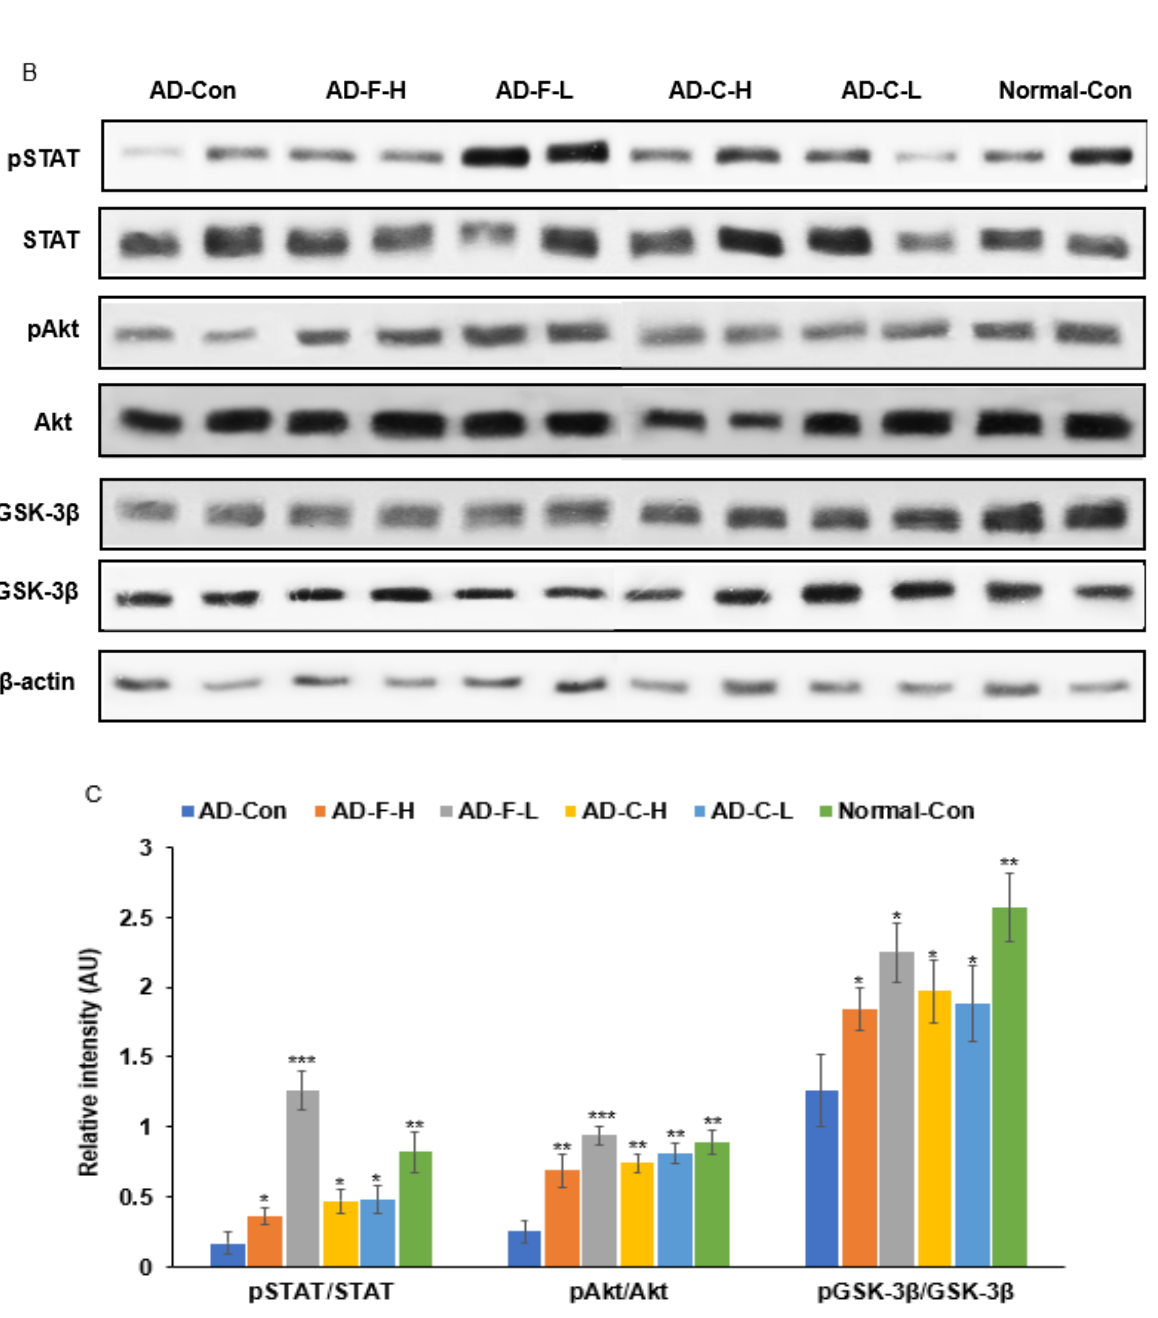
Figure 4. Hippocampal neurotransmitter expression and insulin signaling pathways. ( A ) mRNA expression of ciliary neurotrophic factor (CNTF) and brain-derived neurotrophic factor (BDNF). ( B ) Protein and phosphorylation of proteins in insulin signaling pathways. ( C ) The intensity of proteins and phosphorylation in insulin signaling pathways. The bars and error bars represent the means ± standard deviations ( n = 4). Hippocampal amyloid- β (25–35) infused rats were fed a high-fat diet containing dextrin (AD-Con), fucoidan with high molecular weight (AD-F-H), fucoidan with low molecular weight (AD-F-L), λ -carrageenan with high molecular weight (AD-C-H), and λ -carrageenan with low molecular weight (AD-C-L). The rats in the Normal-Con group had hippocampal saline infusion to have no amyloid- β deposition and were fed a high-fat diet (Normal-Con). * Significant from the AD-Con group at p < 0.05, ** at p < 0.01, and *** at p <